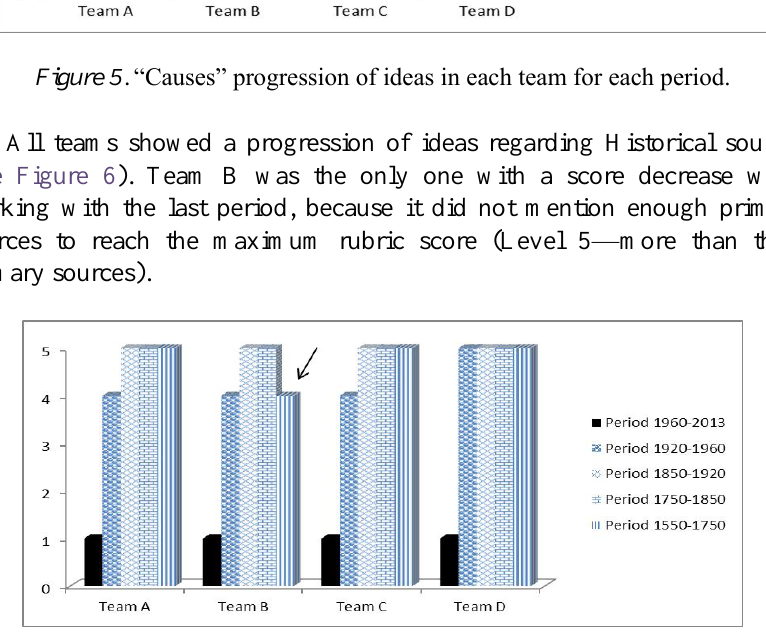
Figure 6 . “Historical sources” progression of ideas in each team for each period. There was progression in all cases when working with the